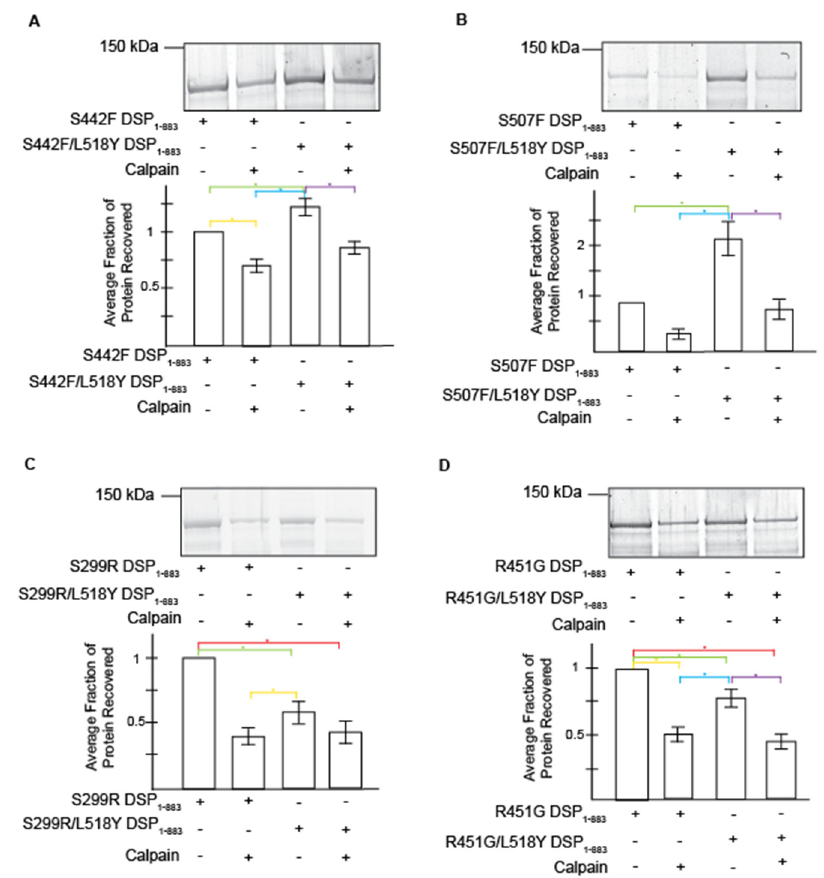
Figure 3. The L518Y mutation partially protects DSP variants from cleavage by calpain. Gels are representative. Graphs show protein recovery ratios as determined by densitometry, for proximal, S442F ( A ) and S507F ( B ), and distal, S299R ( C ) and R451R ( D ) variants. Data are represented by the mean +/- SEM. Statistics were performed with 1-way ANOVA and the Tukey HSD test was used to determine significance. Colored bars represent significance; p < 0.05. Statistics were performed and analyzed in sets: S442F Set, n = 5; S507F Set, n = 6; S299R Set, n = 4; and R451G Set, n = 7. Table 1. L518Y DSP point mutation results in moderate protection from degradation by calpain and decreased surface area of the calpain target site. Average recovery of DSP variants after incu- bation at 37 °C for 30 min with and without calpain. Performance of the secondary L518Y mutation was calculated by measuring the percent change compared to its single mutant counterpart. The corresponding solvent-exposed surface area of the calpain target site (447–451) for each variant is also shown. * p < 0.05 compared to clinical variant without calpain.